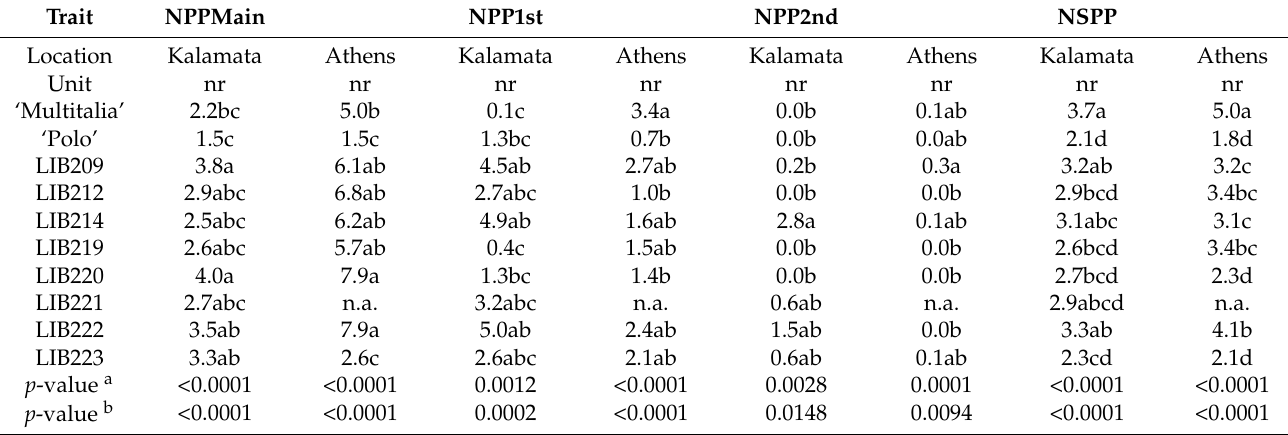
Table 4. Pod traits means among L. mutabilis accessions in comparison to white (‘Multitalia’) and narrow-leafed lupin (‘Polo’) in Kalamata and Athens